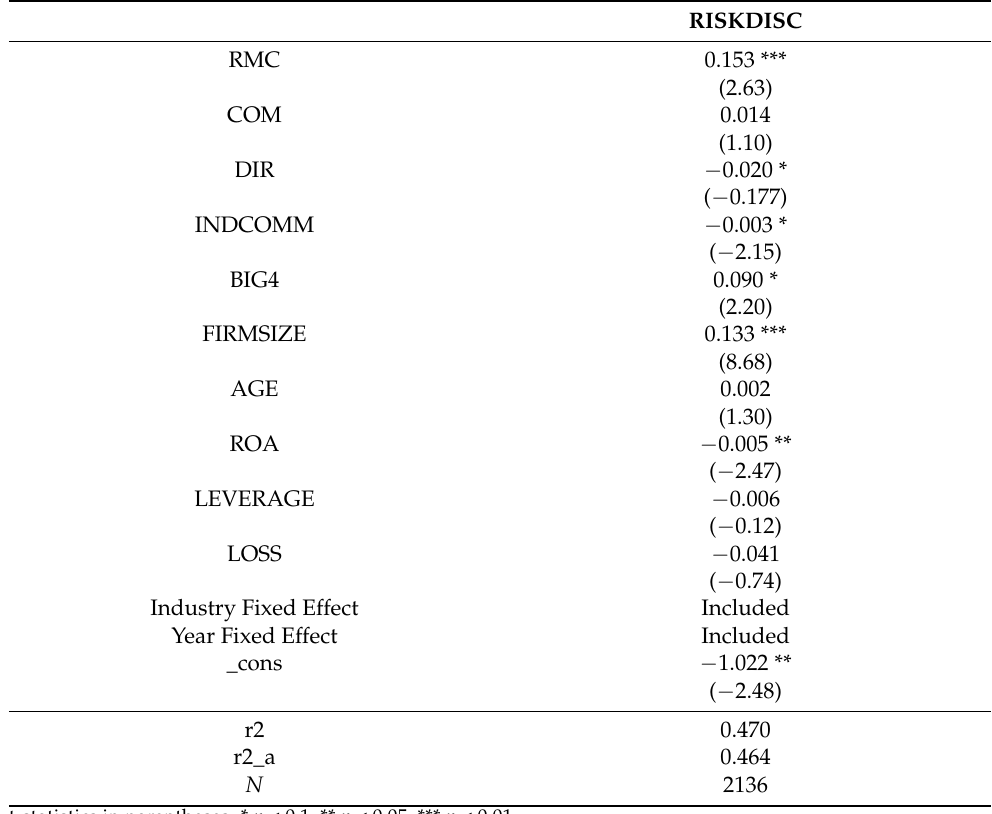
Table 5. Risk management committee and negative